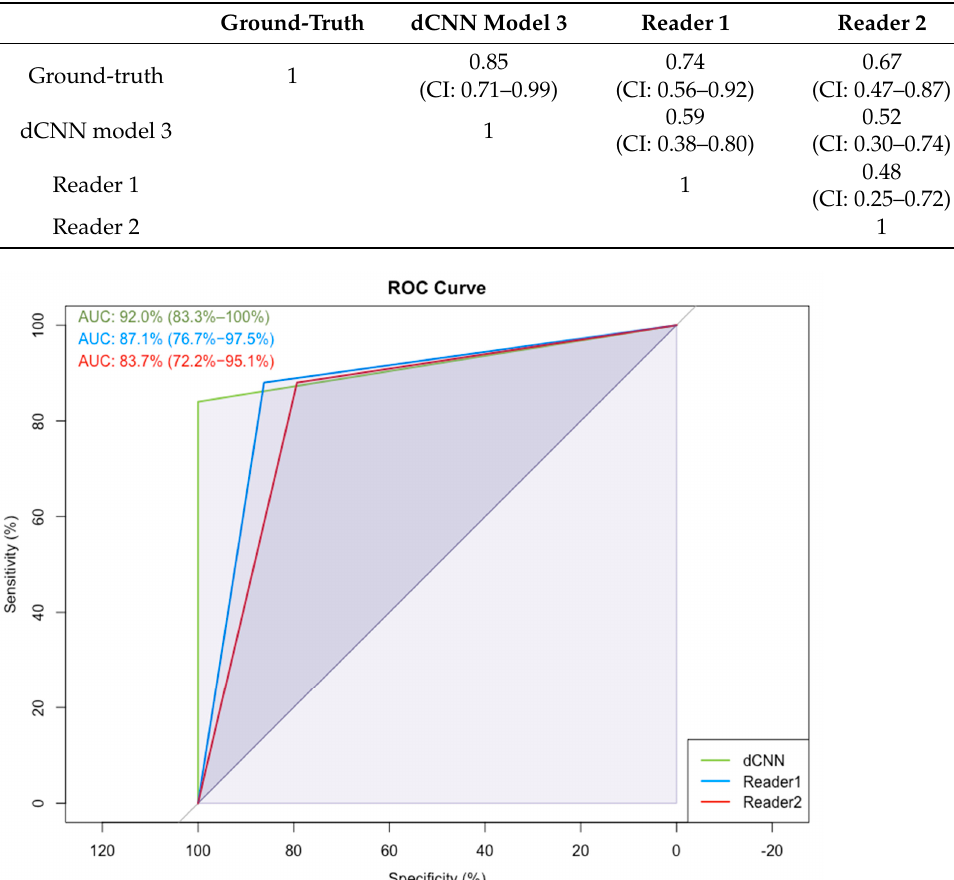
Figure 7. Receiver-operating characteristics (ROC) and the corresponding area under the curve (AUC) for dCNN model 3 and the two readers for the classification “probably benign soft tissue opacity” and “suspicious soft tissue opacity” compared to the radiologist’s report, which served as the ground-truth.